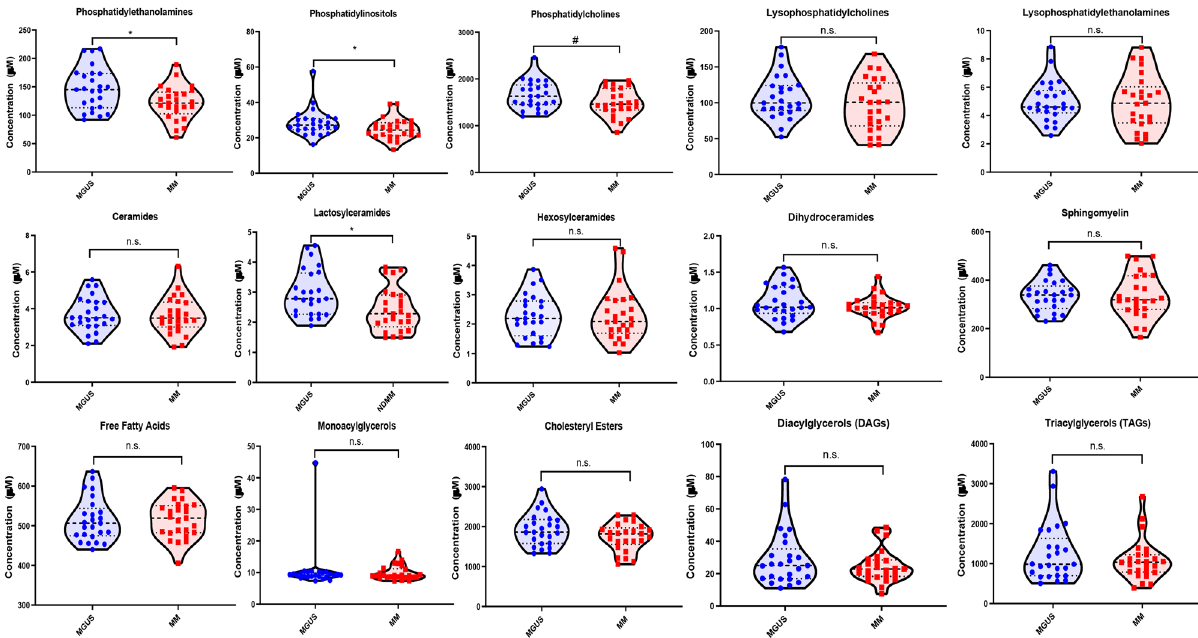
Figure 3. Violin plots comparing the median concentrations of different total species of complex lipids in the bone marrow plasma between MGUS (N = 25) and MM (N = 25) groups. Data was analyzed by Mann-Whitney U test where *** p < 0.001, ** p < 0.01, * p < 0.05, # p < 0.1 but > 0.05, n.s. non-significant.